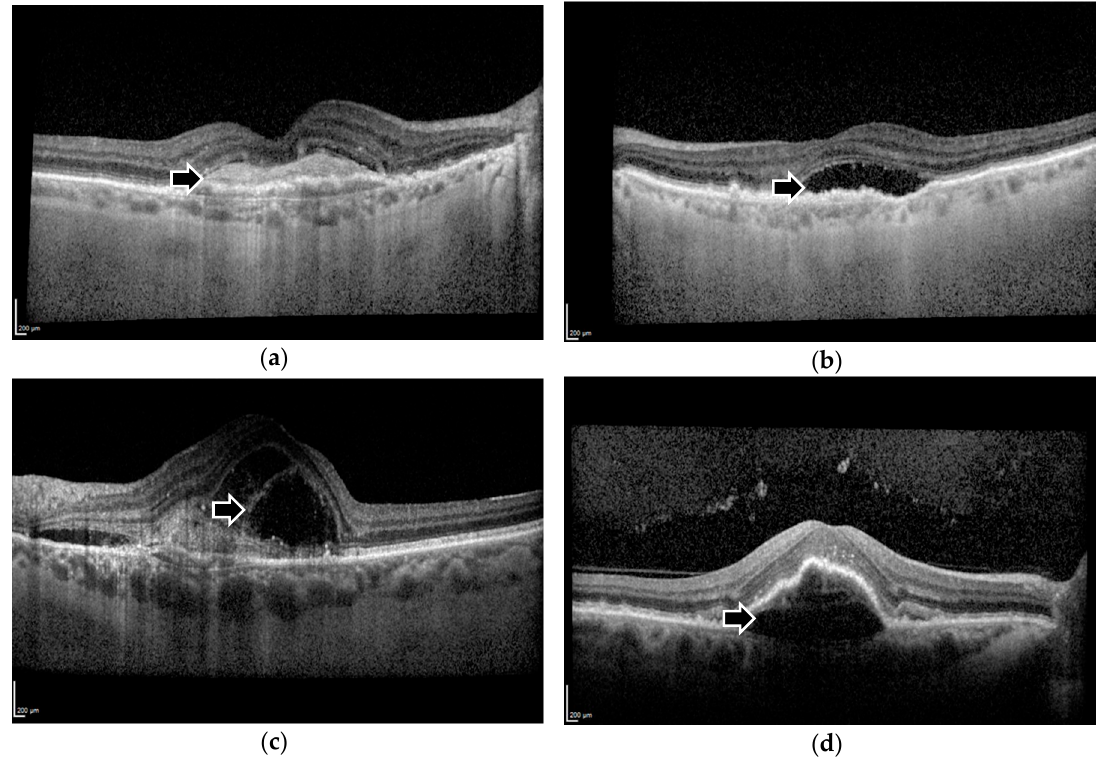
Figure 1. Spectral-Domain Optical Coherence Tomography images demonstrating ( a ) subretinal hyper-reflective material, ( b ) subretinal fluid, ( c ) intraretinal fluid, and ( d ) pigment epithelial detachment. Black arrows indicate the respective morphological features.